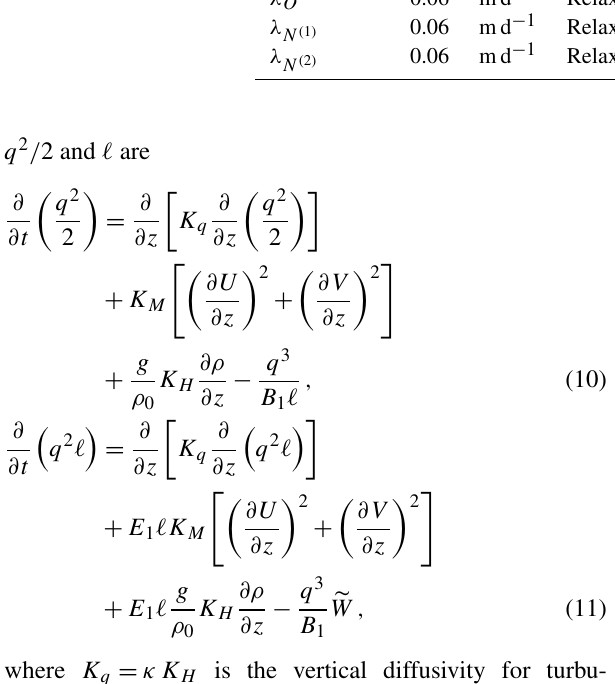
Table 2. Values, units, and descriptions for parameters used in the combined physical–BFM17 model. Symbol Value Units Description v ( set ) Settling velocity of particulate detritus Imposed general circulation vertical velocity 0–0.1 md − 1 Imposed mesoscale circulation vertical velocity